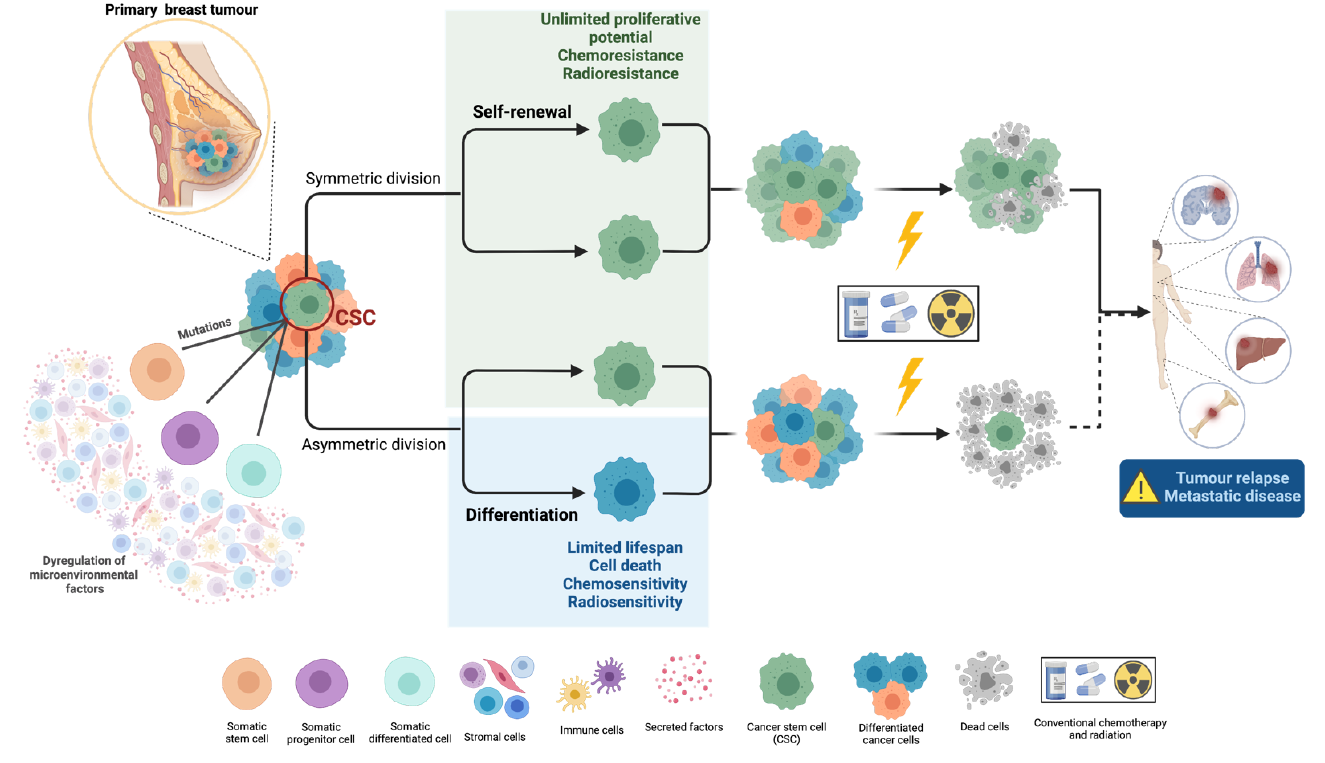
Figure 1. Main features of CSC biology: cell of origin, plasticity, and their role in metastasis. CSCs are characterized by their self-renewal and differentiation capacities, which confers them the ability to form/repopulate heterogeneous cancer cell populations. Moreover, due to their enhanced mechanisms of chemo- and radioresistance, CSCs are considered as the main responsible for tumour recurrence and metastases. Generally, CSCs divide asymmetrically, giving rise to a CSC and a differentiated cell that integrates with tumour bulk. However, under stress conditions, as cell loss during anticancer treatment, they can also divide symmetrically, originating two CSCs, which allows the excessive promotion of tumour growth and repopulation. Biorender: https://biorender.com (accessed on 12 January 2022).